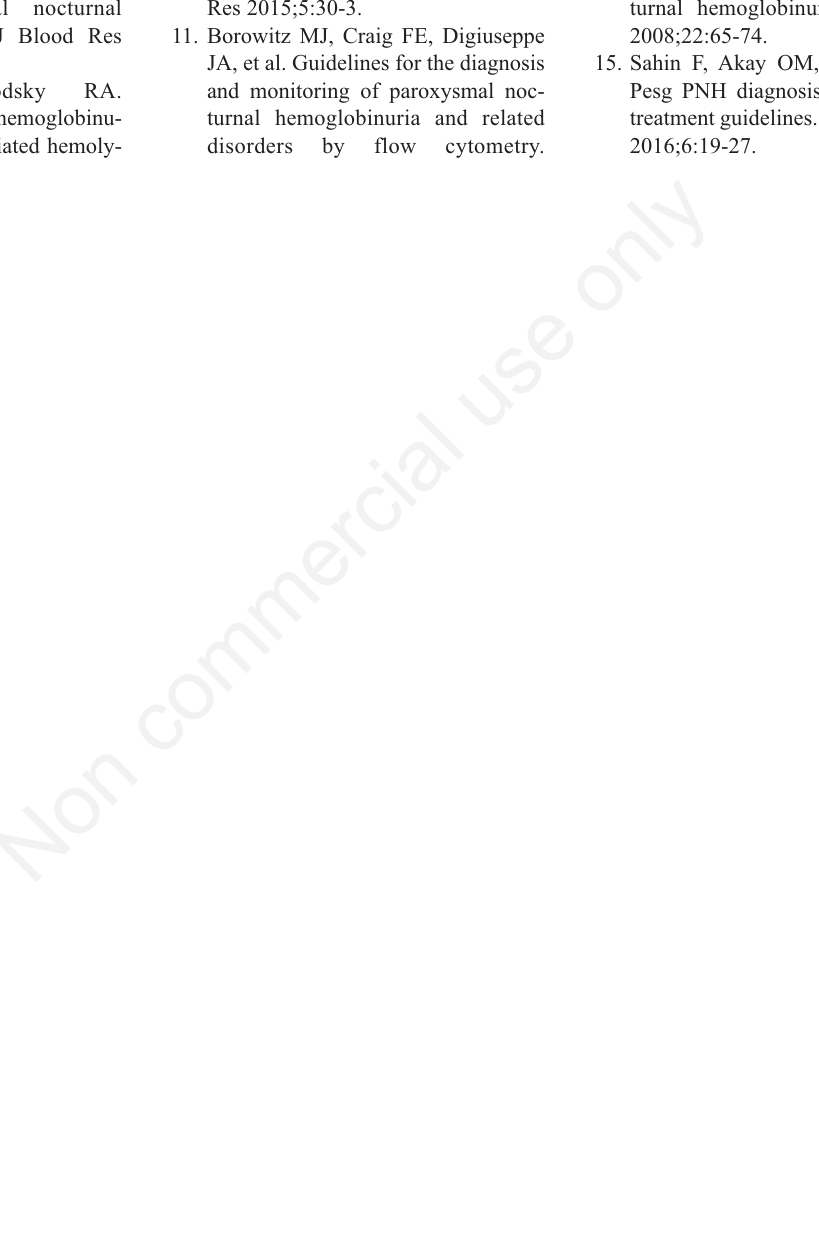
table disease: same disease, different clinical presentations. Am J Blood Res